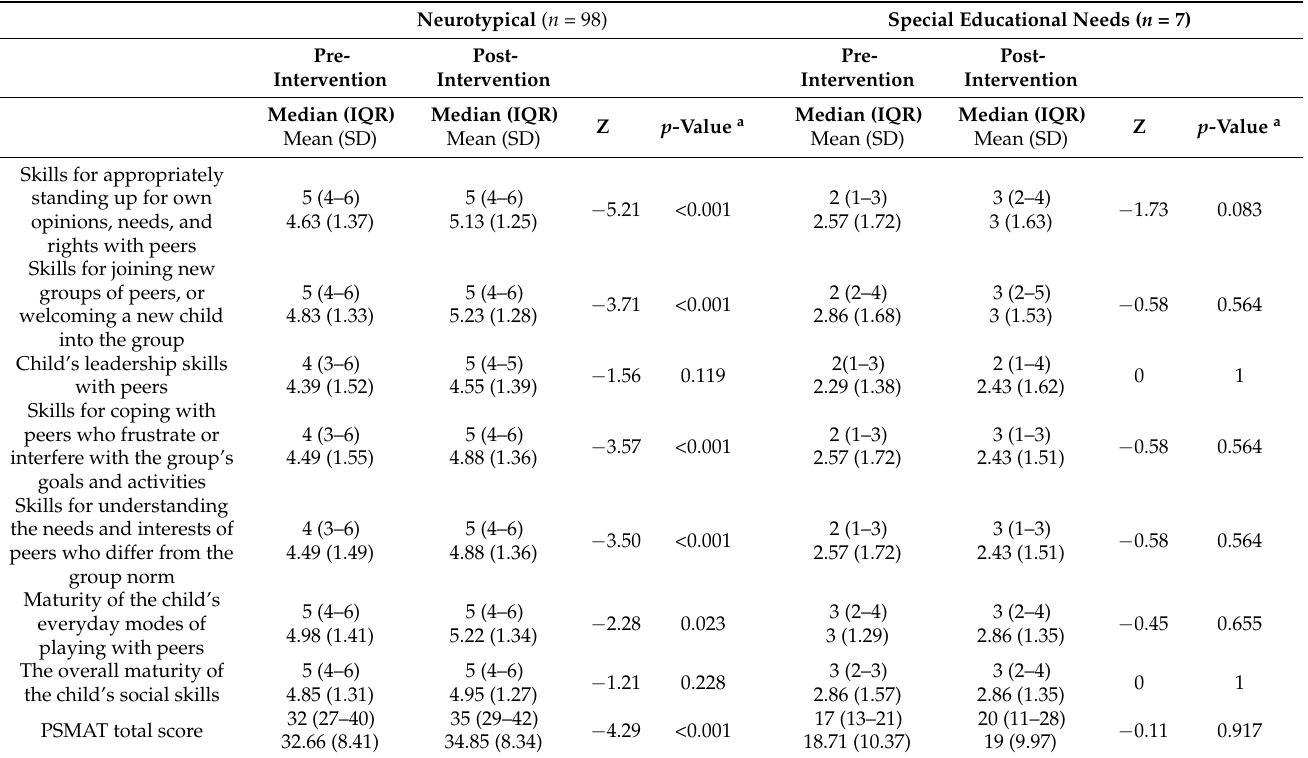
Table 3. Peer Social Maturity Scale (PSMAT) Items. Pre-post intervention differences in the